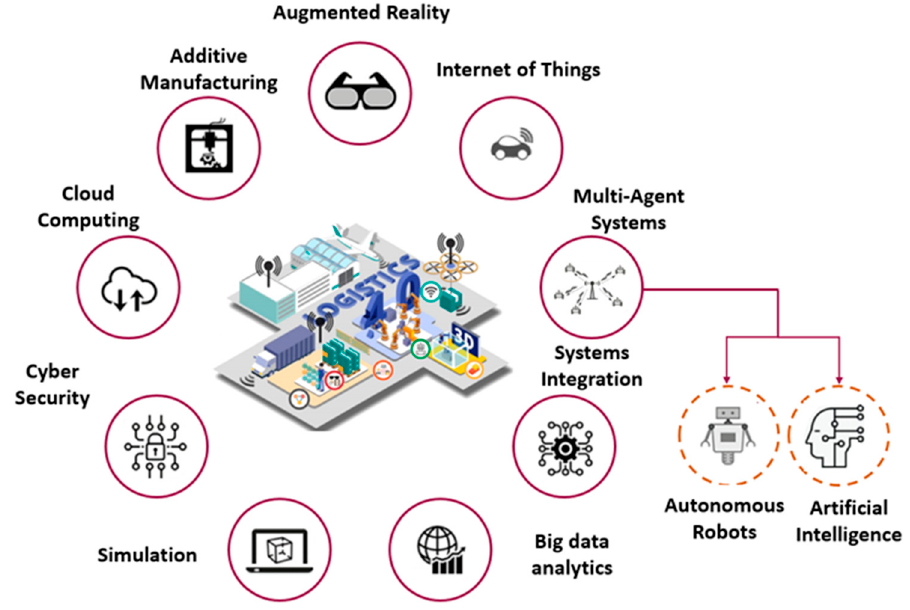
Figure 2. Main pillars of Industry 4.0 concept.